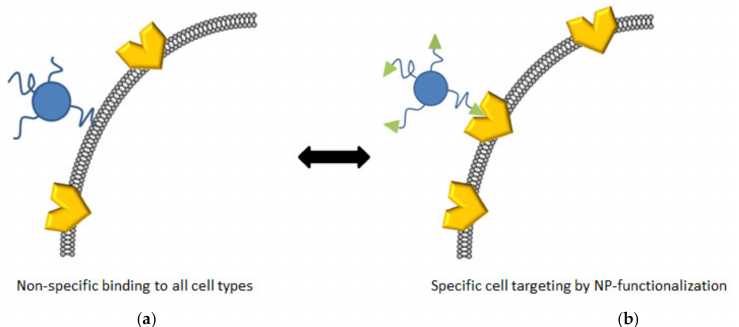
Figure 5. Non-specific CPNP–cell interactions ( a ) vs. specific cell targeting via the introduction of functionalities on the CPNPs that bind selectively to receptors present on the cells of interest ( b ).